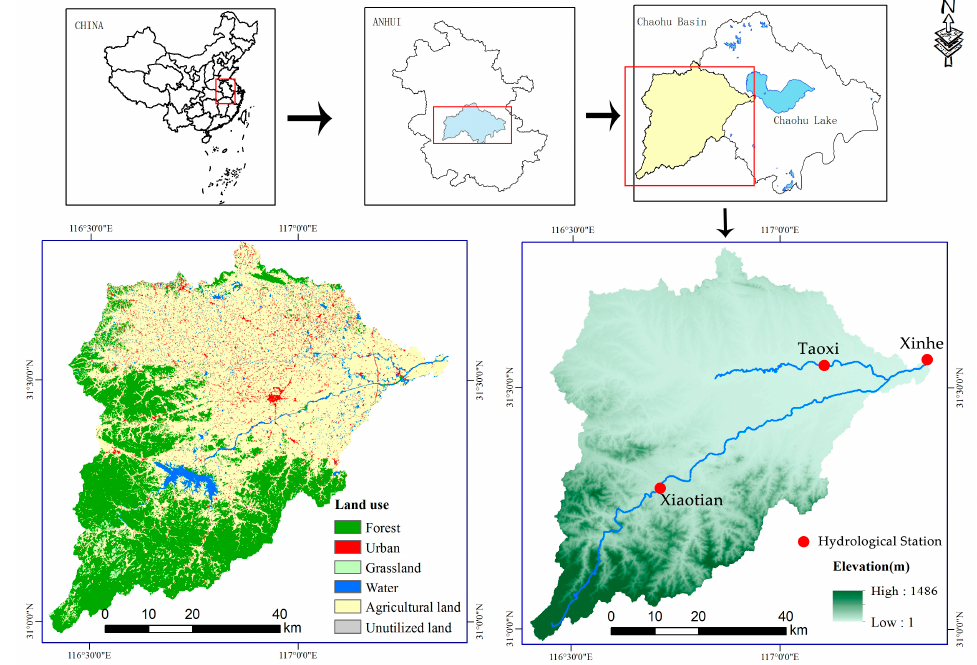
Figure 1. Locations of study area and samples.